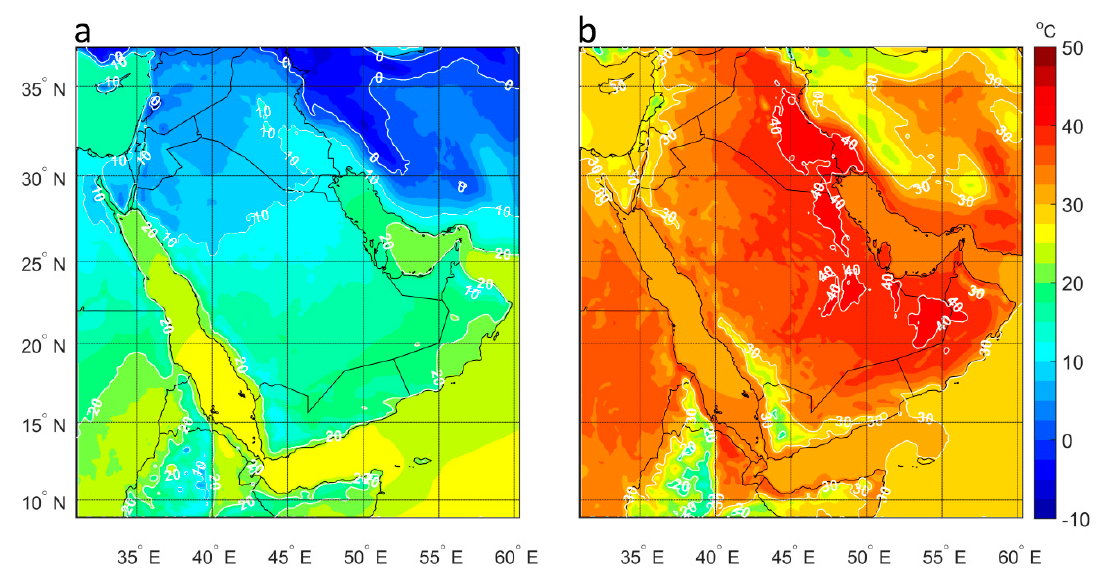
Figure 9. Mean annual distribution of the ( a ) 5th and ( b ) 95th quantile of temperature at 2 m.